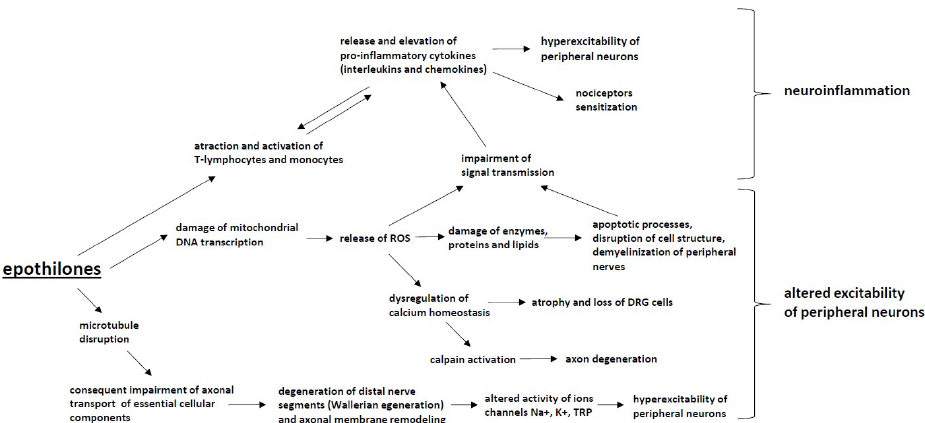
Figure 4. The mechanisms of CIPN induced by epothilones: Epothilones cause microtubule disruption, which impairs axonal transport and leads to Wallerian degeneration, the altered activity of ion channels and the hyperexcitability of peripheral neurons. Furthermore, the damage to mitochondria by epothilones leads to an increased production of reactive oxygen species (ROS), resulting in enzyme, protein and lipid damage within neurons as well as apoptotic changes to peripheral nerve. These processes lead to altered excitability of peripheral neurons. ROS release and the attraction and activation of T-lymphocytes and monocytes also induces the release and elevation of pro-inflammatory cytokines (interleukins and chemokines), the activation of immune cells and the development of